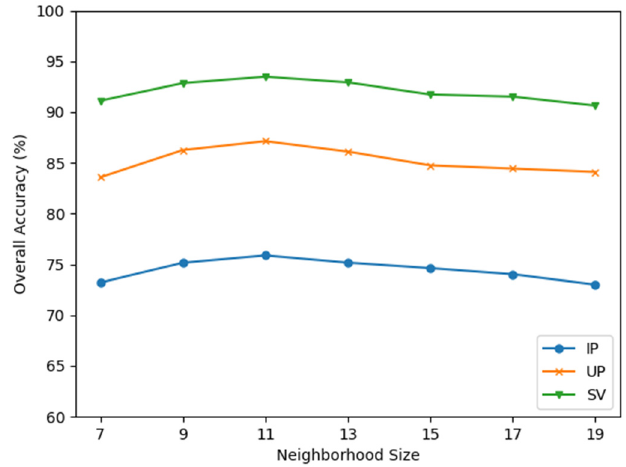
Figure 12. OAs obtained by GDAFSL with various neighborhood sizes on three HSI datasets.